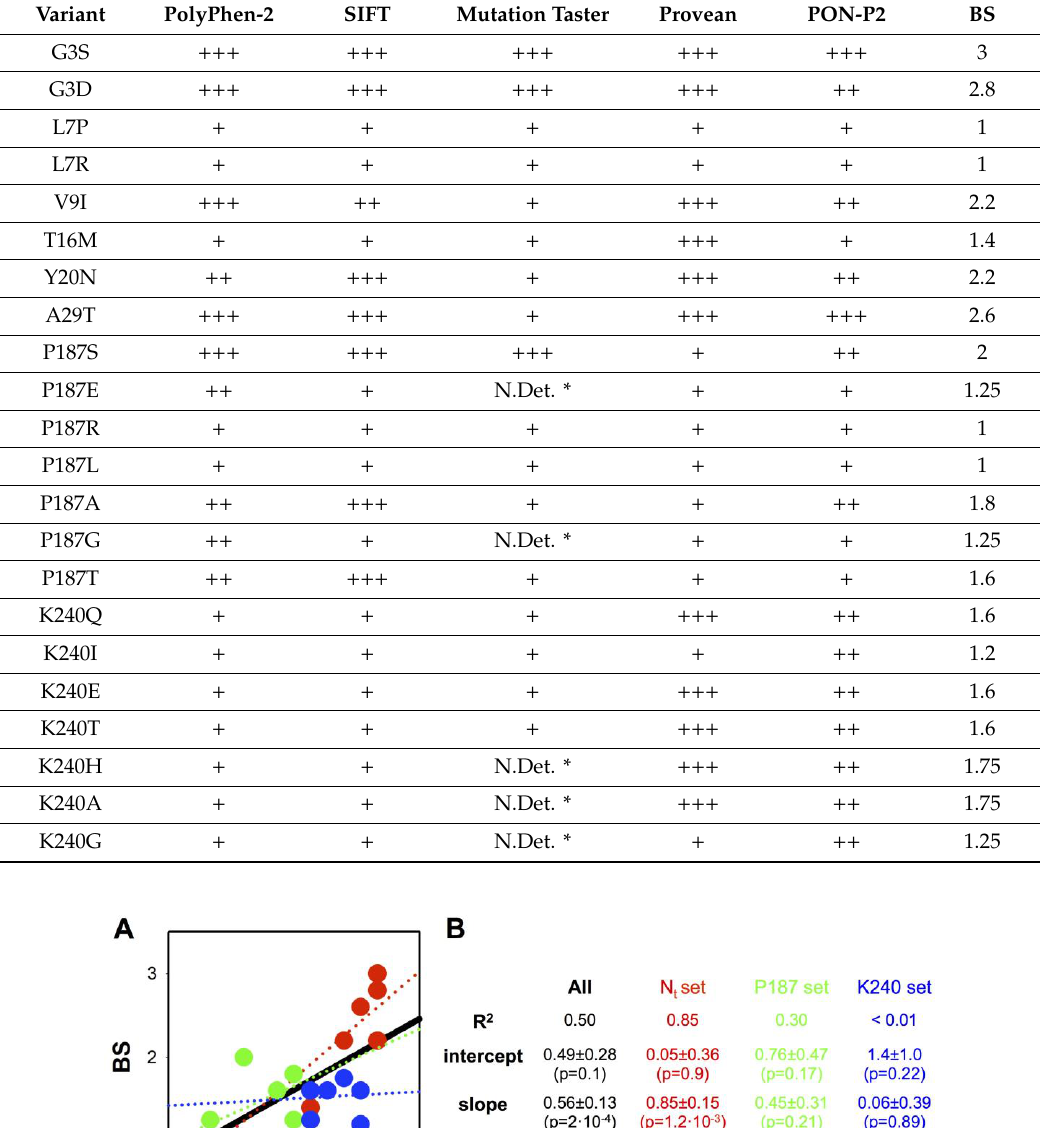
Table 4. Classification of phenotypic consequences of NQO1 mutations based on bioinformatic analysis. The bioinformatic scores (BSs) are calculated as the average from individual scores provided by di ff erent algorithms as follows: Polyphen-2: +++ , Benign; ++ , Possibly damaging; + , Probably damaging; SIFT: +++ , tolerated; + , Not tolerated; Mutation Taster: +++ , polymorphism; + , disease-causing; Provean: +++ , neutral; + , deleterious; PON-P2: +++ , neutral; ++ , unknown; + , pathogenic. * N.Det.- not determined because two nucleotide have to change.